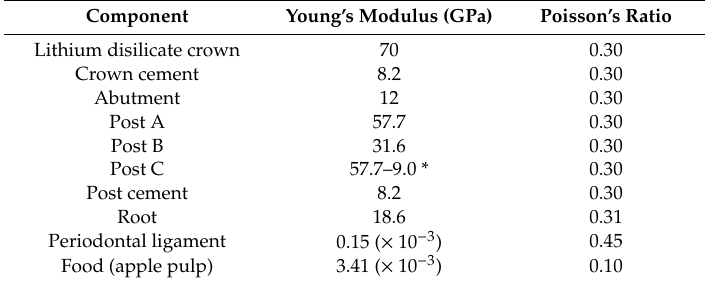
Table 1. Young’s moduli and Poisson’s ratios for different model components.